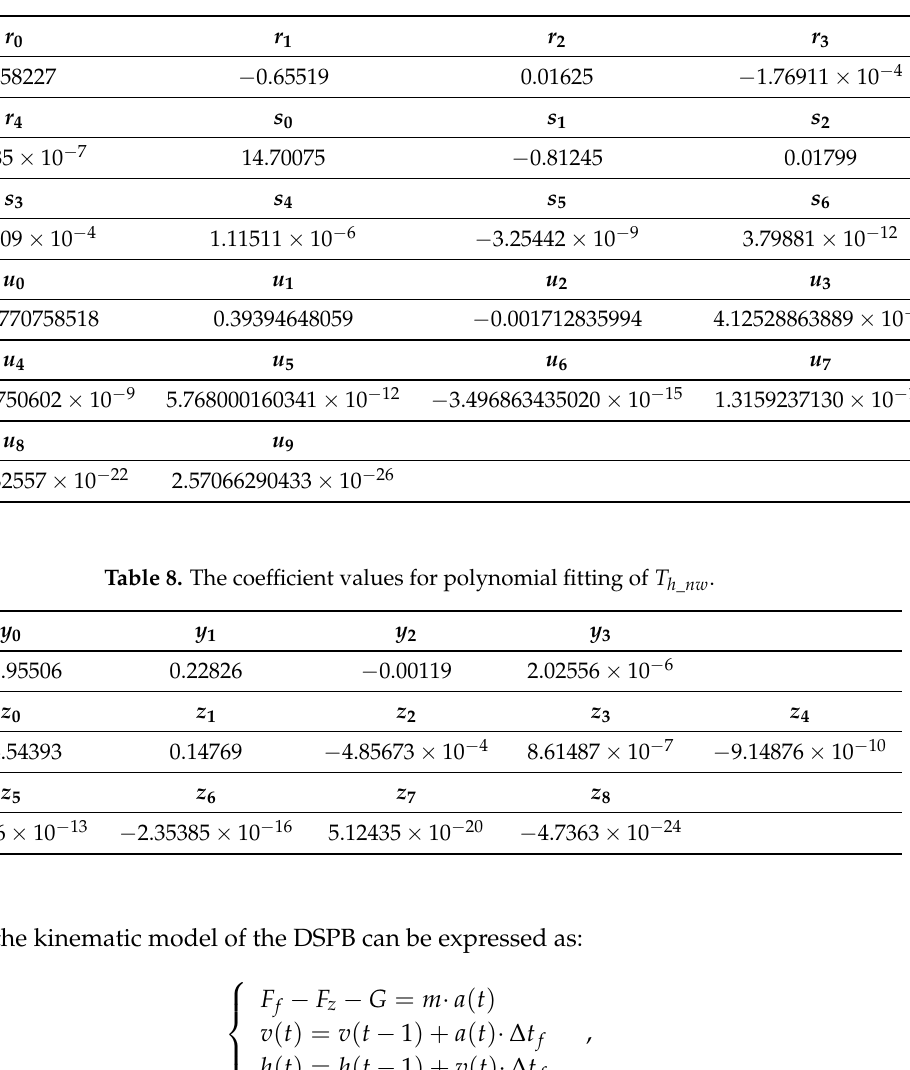
Figure 11. The fitting result of the temperature data in the nouthern hemisphere. Panel ( a ) shows the seawater’s temperature data in summer and ( b ) shows the seawater’s temperature data in winter. Table 7. The coefficient values for polynomial fitting of T h _ ns .